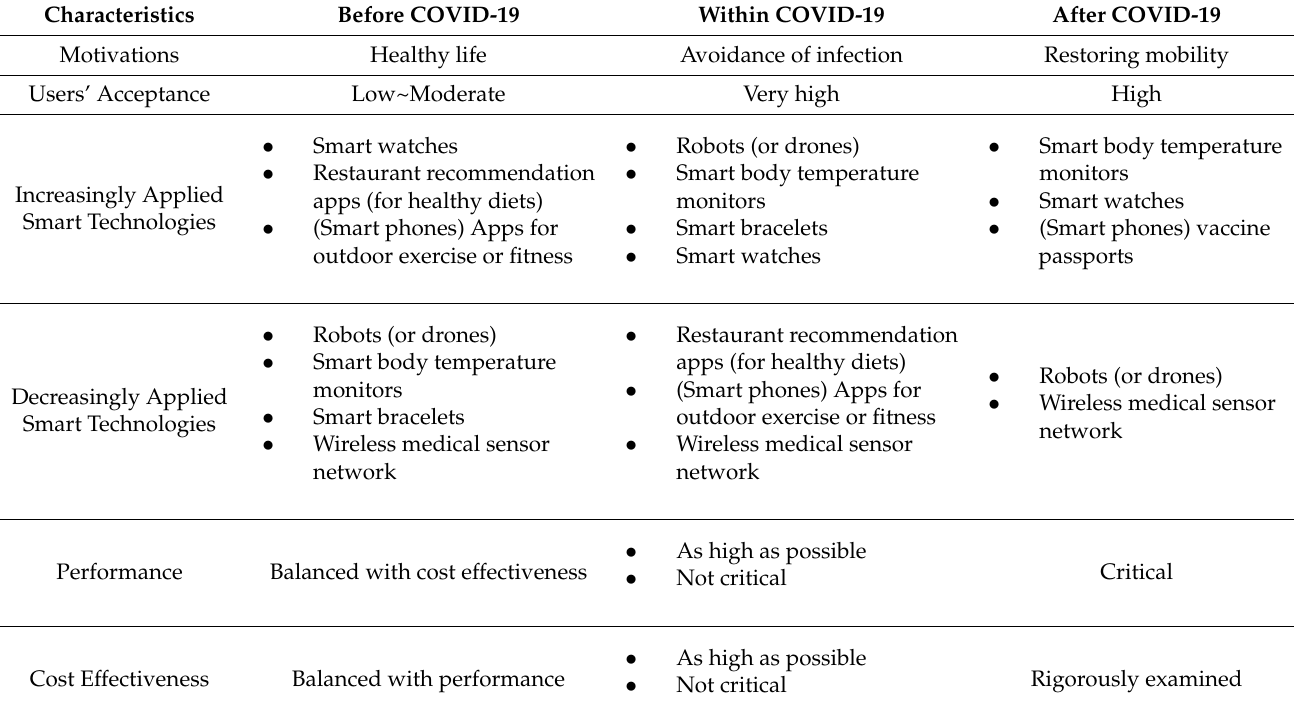
Table 1. Summary of the discussion